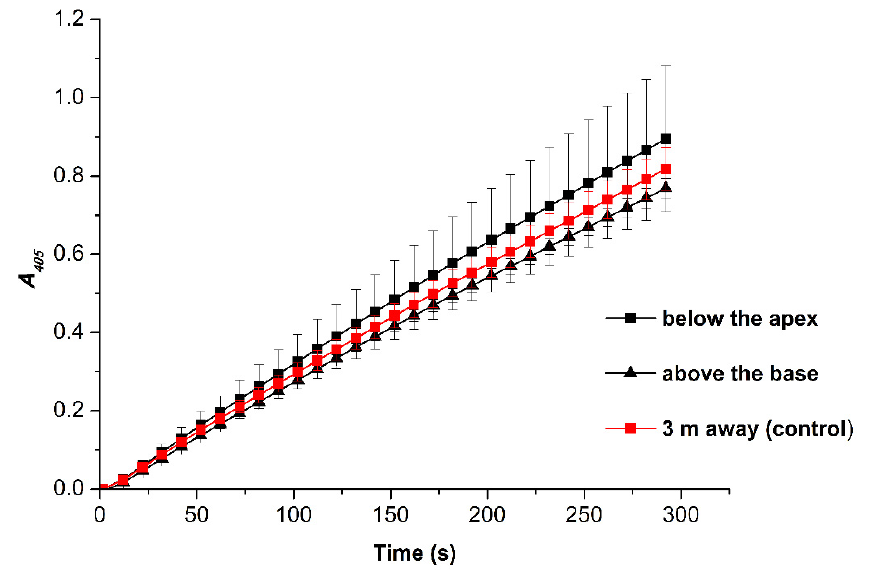
Figure 5. The time dependencies of the change in absorbance of 0.3 mM ABTS solution containing 1 nM HRP and 2.5 mM hydrogen peroxide. Experimental conditions: cell pathlength 1 cm, room temperature 25 °C.